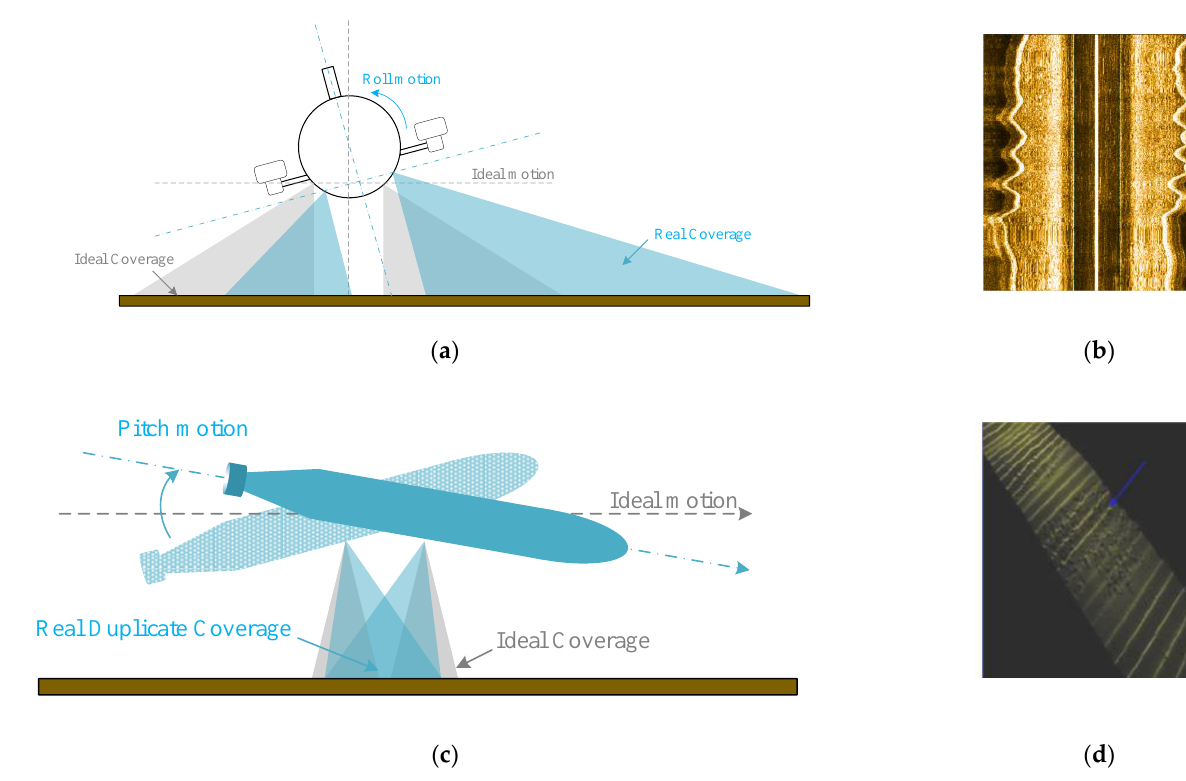
Figure 1. The abnormal sonar image caused by unstable attitude. ( a ) The ideal roll angle is zero degrees, and the left and right swept areas of the side scan sonar are the same. When the roll angle oscillates around zero degrees, the area covered by the left and right scans is asymmetrical, such as the blue-shaded part, which causes the image to be distorted, as shown in ( b ). ( c ) The ideal pitch angle is also zero degrees. Continuous oscillation will cause multiple scans of the same area, resulting in streak-like abnormal images in ( d ).